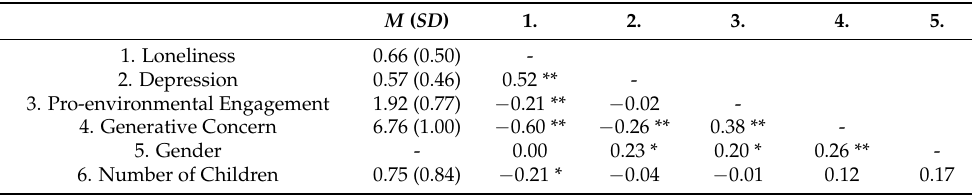
Table 1. Descriptive and correlations among